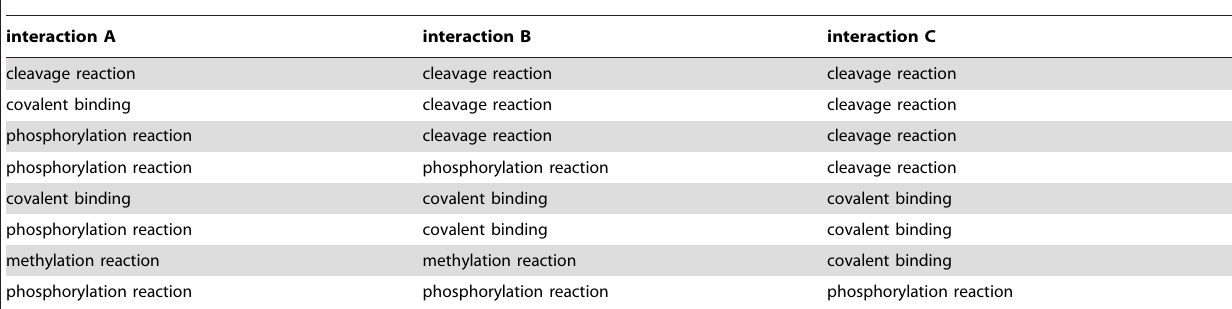
Table 2. Significantly recurring network